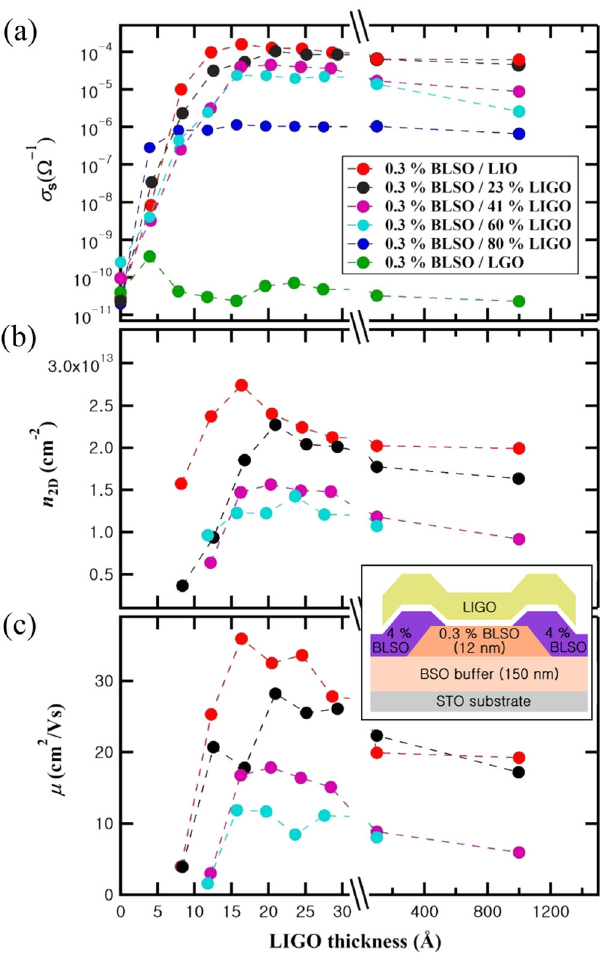
Fig. 1 Electrical transport properties of the LIGO/0.3% BLSO interfaces. a Conductance ( σ s ), b sheet carrier density ( n 2D ), and c Hall mobility ( μ ) as a function of the LIGO thickness for various Ga alloying contents. The inset is a cross-sectional schematic diagram of the BLSO/LIGO interfaces.